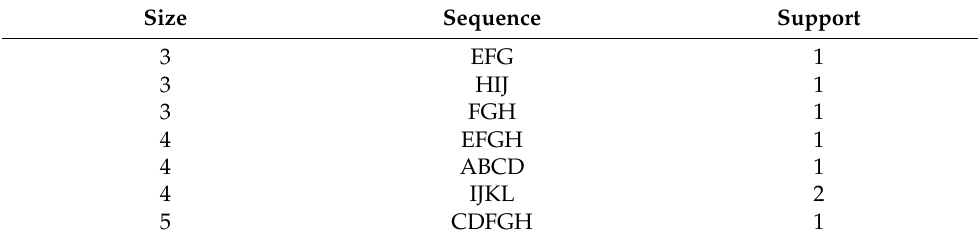
Table 6. Large 3, 4, and 5 sequences.